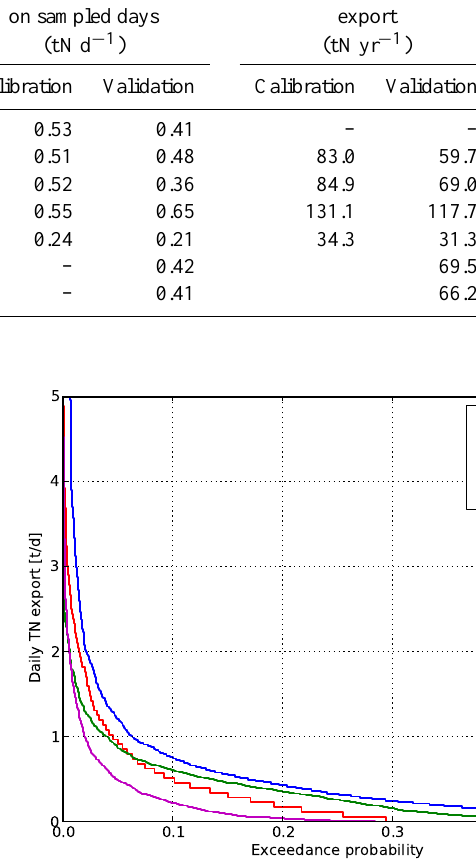
Table 3. Model calibration (1989–1997) and validation (1998–2006) results. Model